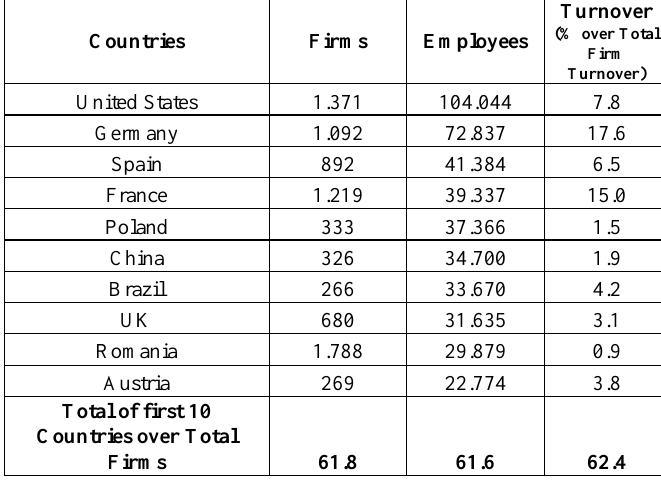
Table 4: Location of Italian Companies Abroad in 2011. Top Ten Countries